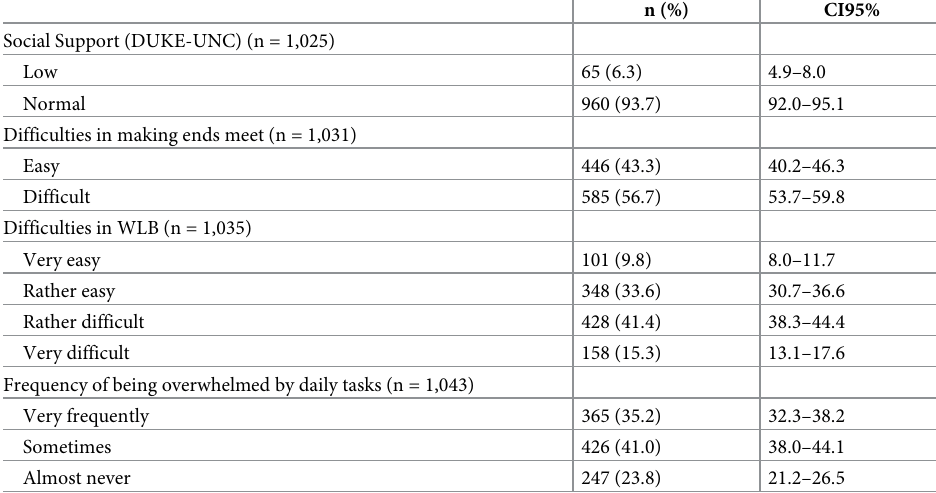
Table 3. Domestic and family